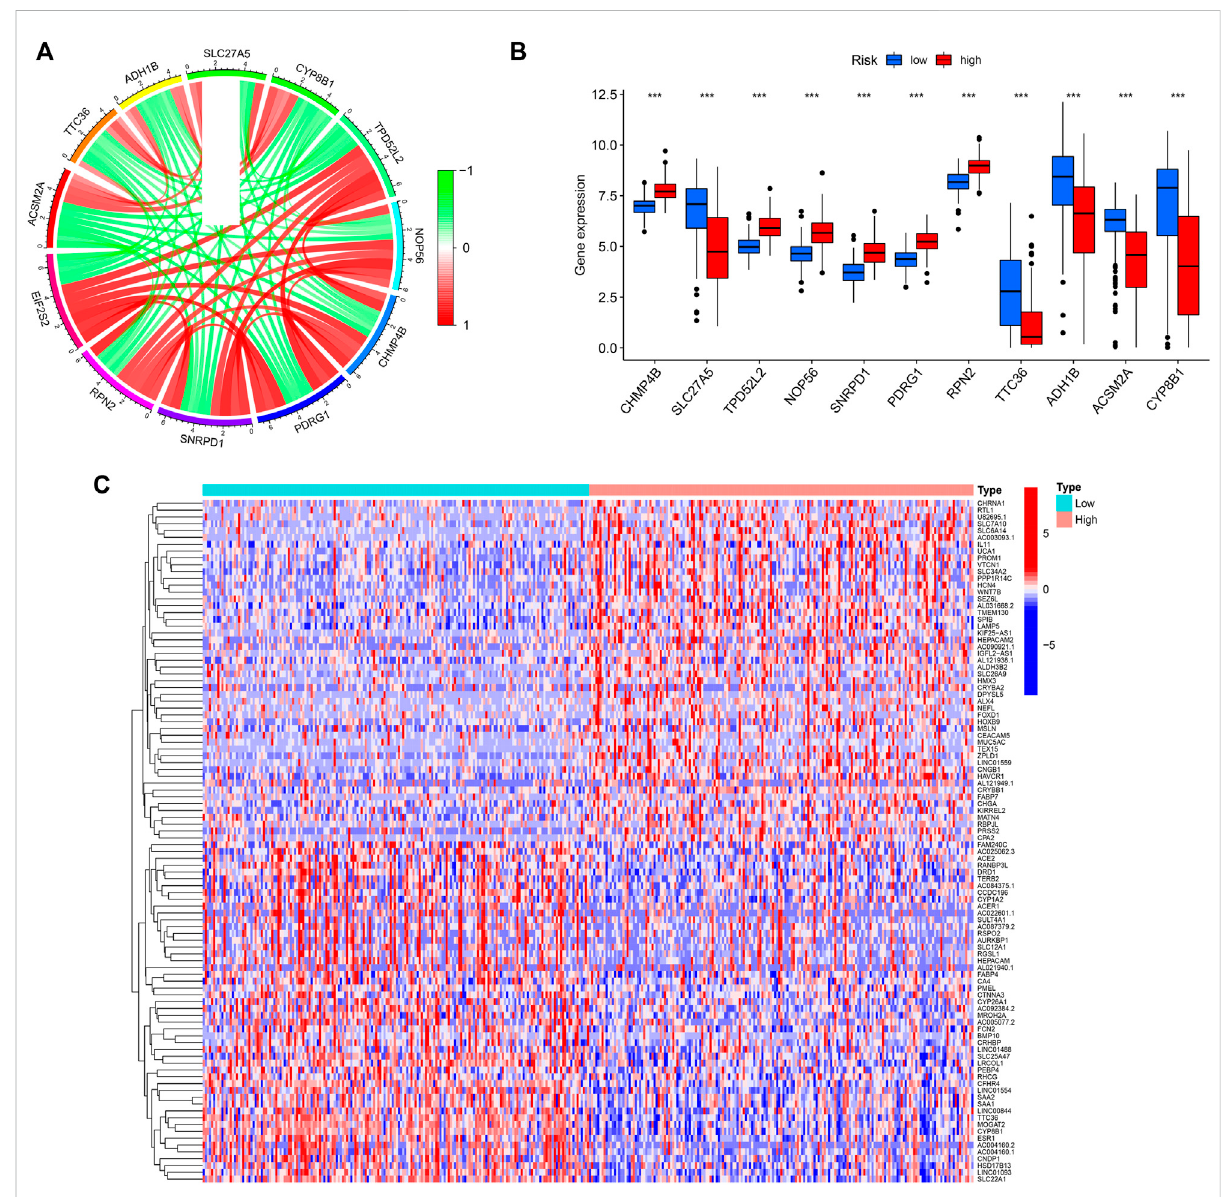
FIGURE 4 Results of co-expressed analysis. (A) Co-expressed genes of EIF2S2. (B) Differences in the expression of Co-expressed genes in different expression groups. (C) Heatmap of Differential